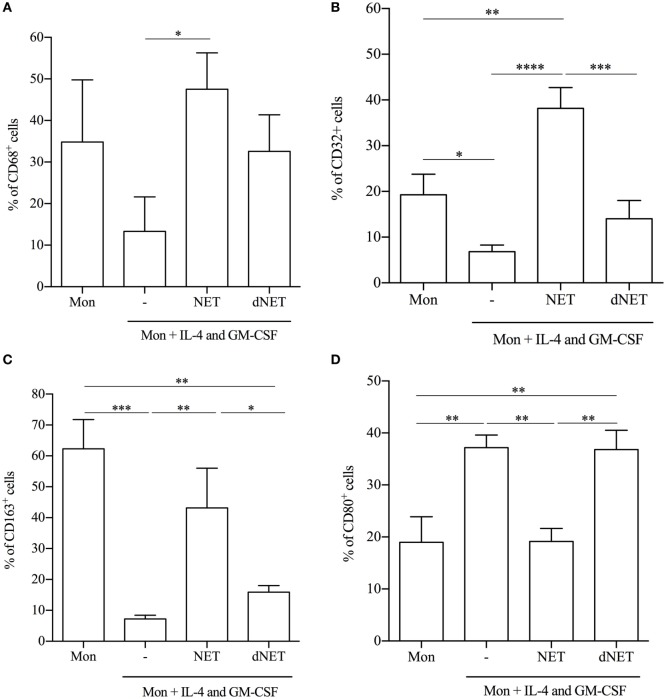
Neutrophil extracellular traps (NETs)-treated monocytes differentiate into macrophages. Adhered monocytes were incubated or not with NETs-enriched supernatants or digested NETs (dNETs) for 18 h. IL-4 and GM-CSF were added to the culture (where indicated) and the cells were maintained at 37°C/5%CO2. (A–D) After 5 days, cells were harvested and stained for (A) CD68, (B) CD32, (C) CD163, and (D) CD80. Results of at least five experiments are shown as % of cells expressing the cell marker and as mean ± SEM. (A) *P < 0.05. (B) ****, ***, **P < 0.001; *P < 0.05. (C) ***, **P < 0.01; *P < 0.05. (D) **P < 0.05.